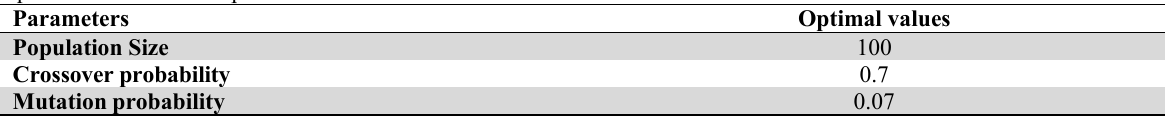
Optimal Values for MA